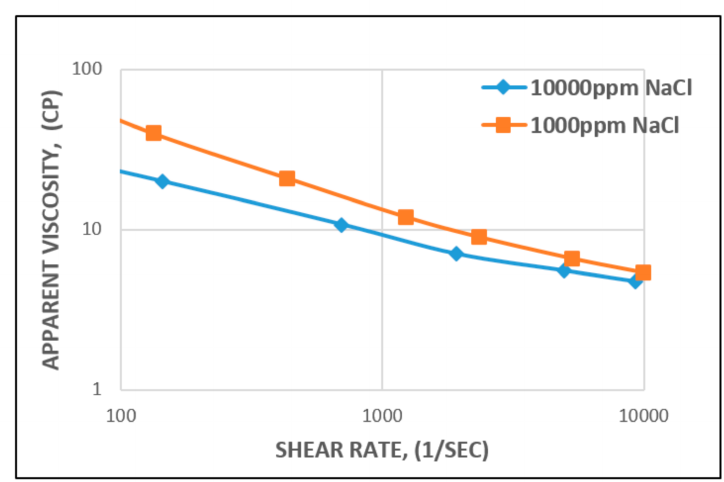
Figure 13. Influence of salinity (Na + ) on the viscosity of HPAM at di ff erent concentrations.